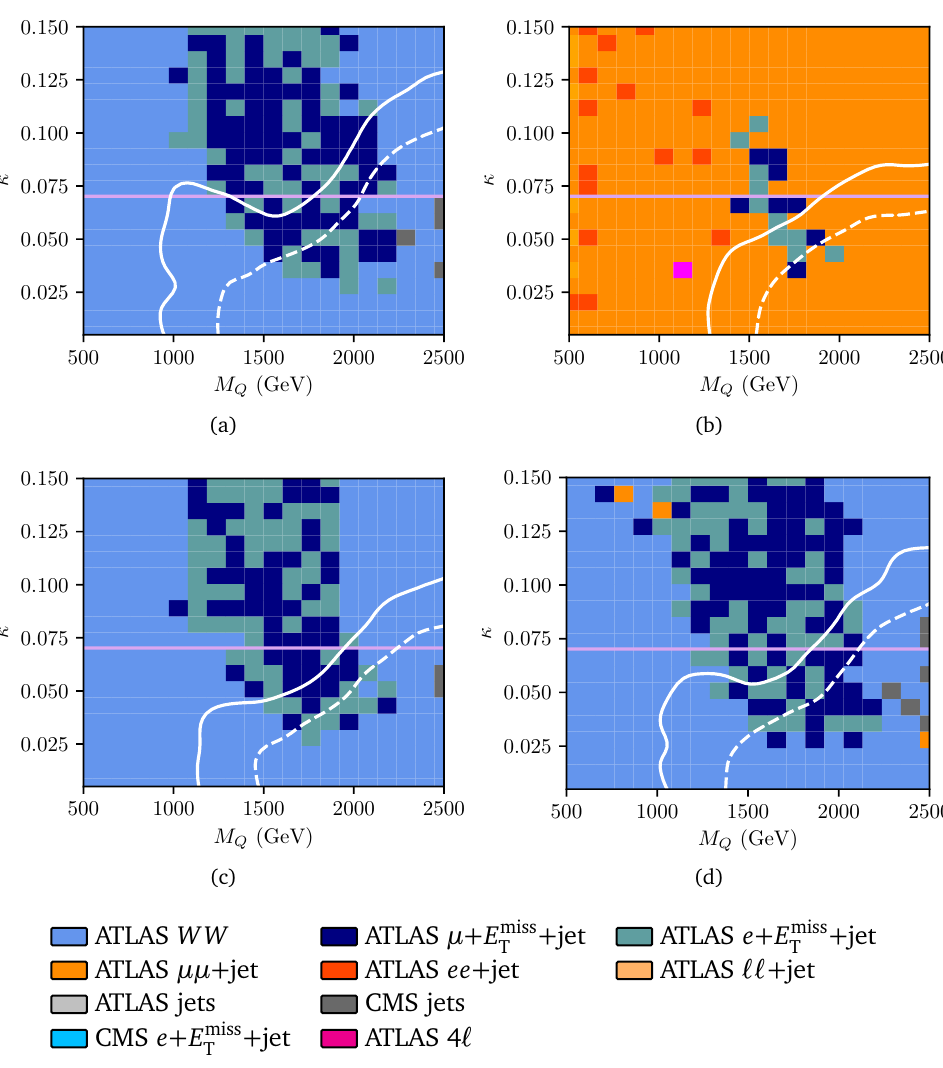
Figure 7: Dominant LHC analysis pools contributing to VLQ limit-setting in the κ vs VLQ mass plane, where κ is the coupling to first-generation SM quarks. All VLQ ( B , T , X , Y ) masses are set to be degenerate. The disfavoured regions are located above and to the left of the dashed (68% CL) and solid (95% CL) white contours respectively. The lower bounds in κ from non-LHC flavour physics are indicated with the pink horizontal contour. The VLQ branching fractions to W : Z : H are (a) 0:0:1 (b) 0:1:0 (c) 1:0:0 and (d) 1 : 1 : 1 2 4 4